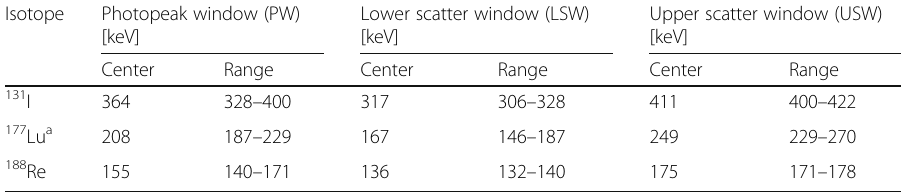
Table 3 Energy window settings for 131 I [37], 177 Lu [38], and 188 Re [39] used in the experimental acquisitions and in the simulations Isotope Photopeak window (PW) Lower scatter window (LSW) [keV]